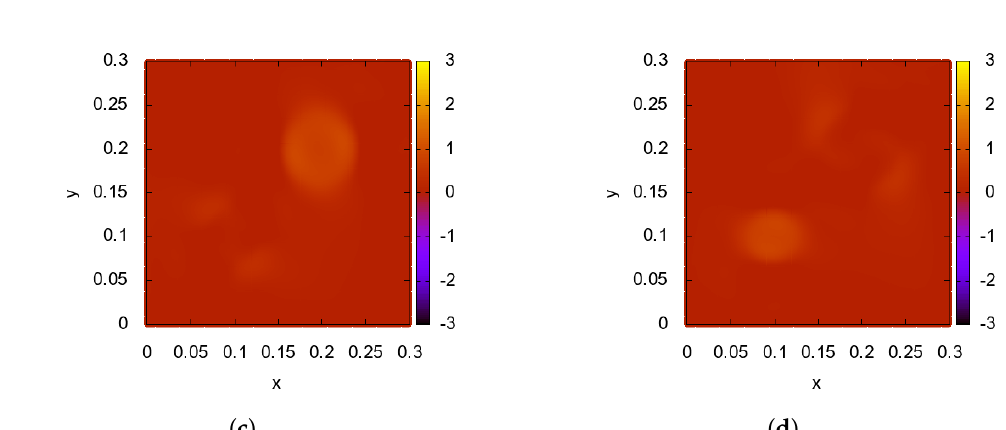
Figure 4. Test 1. Inverse problem 2. Reconstruction result after 1500 iterations (noisy data). Level of noise is 5% (graphs ( a , b )) and 10% (graphs ( c , d )). Graphs ( a , c )—result of the reconstruction of the function q 1 ( x , y ) ; Graphs ( b , d )—reconstruction of the function q 2 ( x , y ) .